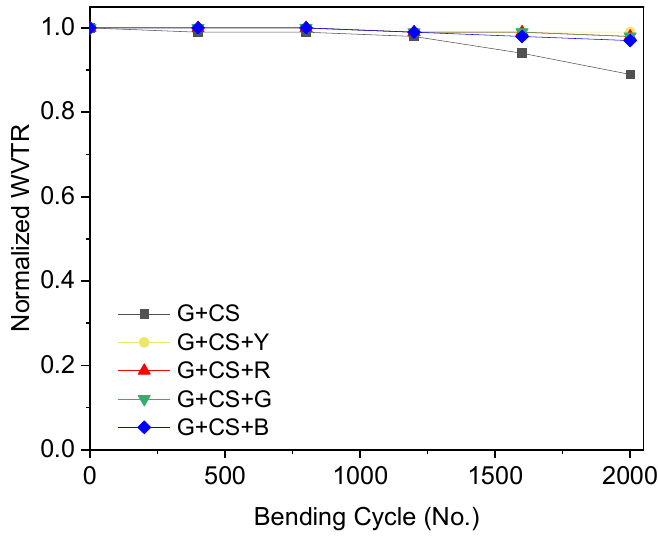
Figure 6. Normalized WVTR value of gelatin–cornstarch-based edible films with red, blue, green, and yellow food color plotted against the number of bending cycles at a bending radius of 6 cm. The black curve represents the pristine G+CS film, the red curve represents the G+CS+R film, the blue curve represents the G+CS+B film, the yellow curve represents the G+CS+Y film, and the green curve represent the G+CS+G film vs. the number of bending cycles. All the rested films had a thickness of 100 µm.